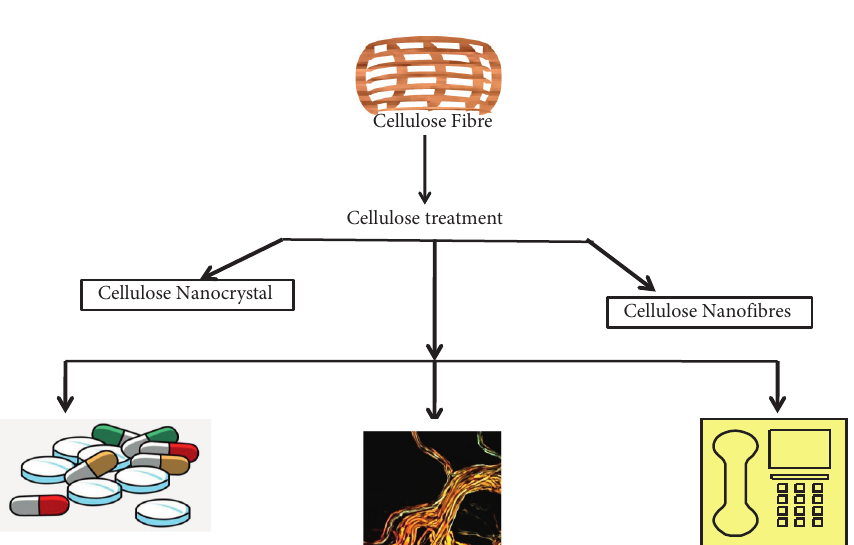
Figure 8: Flowchart of utilization of cellulosic fibres in different